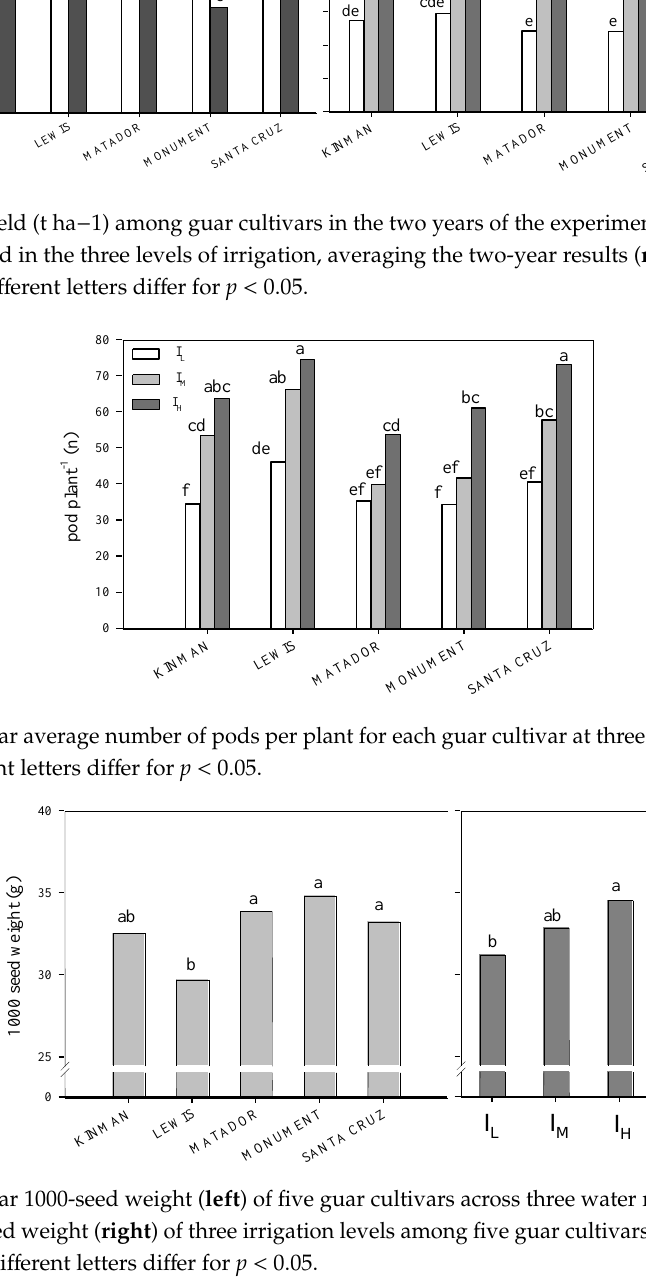
Italy. Bars with di ff erent letters di ff er for p < Ispica, Italy. Bars with different letters differ for p < 0.05.